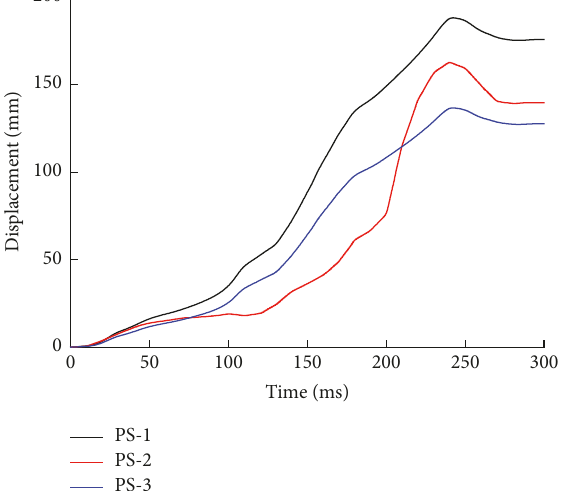
Figure 21: Displacement time-history curves under different con- crete strengths.